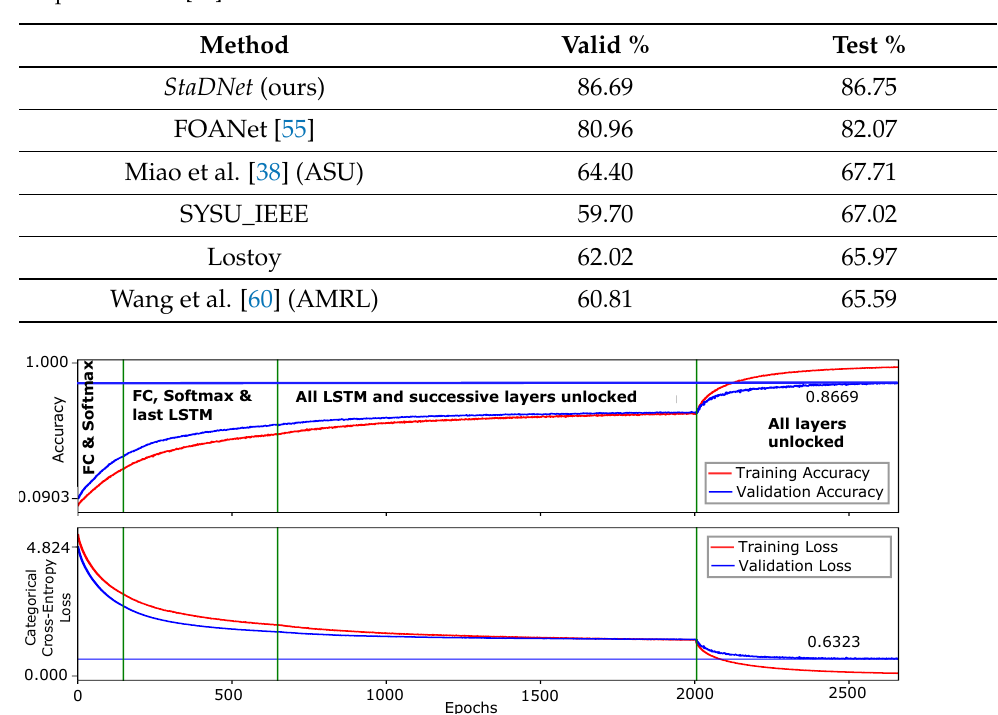
Table 1. Comparison of the reported results with ours on the Chalearn 2016. The challenge results are published in [59].